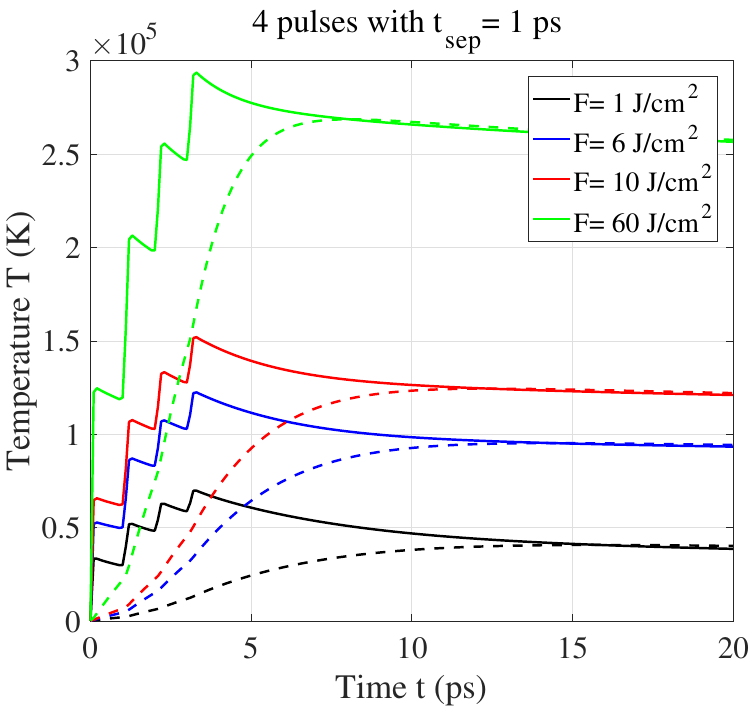
Figure 5. The time dependence of the calculated electron (solid line) and lattice (dash line) temperatures at different laser fluences with 4 pulse and 1 ps (1 THz) of separation time (repetition